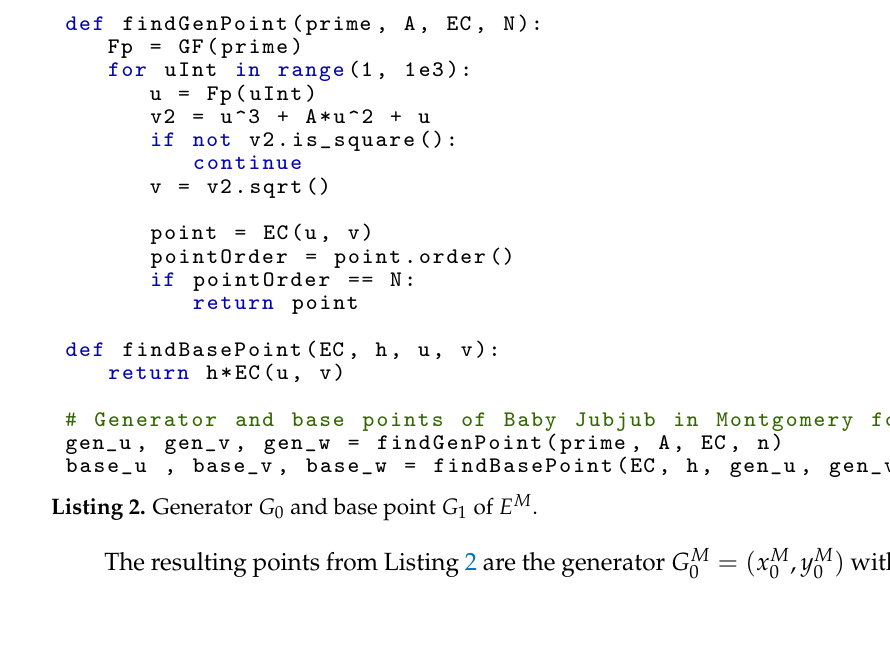
Algorithm 3 maps a Montgomery curve to its twisted Edwards form. We divided the 428 algorithm in three different functions. The first function mont_to_ted converts a Mont-